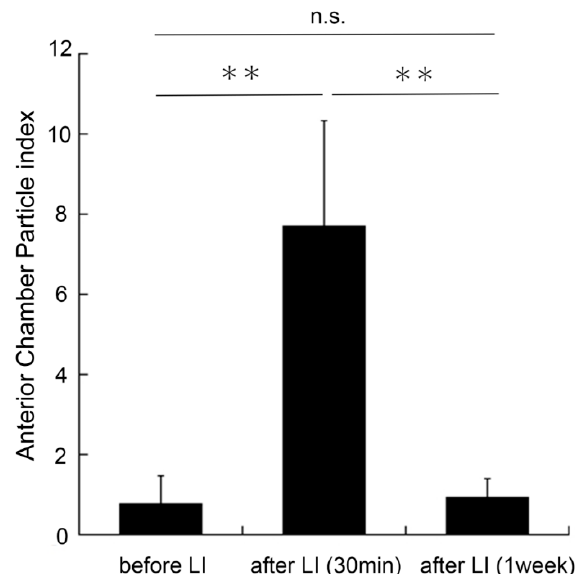
Figure 3. Anterior chamber particle (ACP) index before and after laser iridotomy (LI). ** p < 0.01